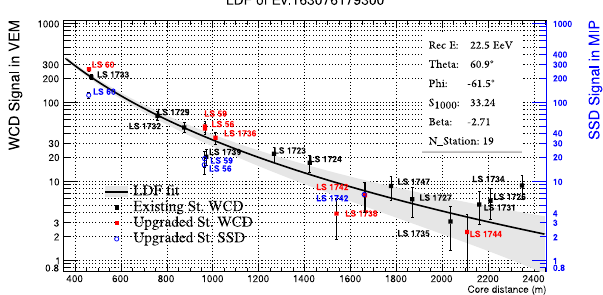
Figure 3: Left panel: WCD and SSD signals in the same station for an event. Right panel: Correlation between sizes of the SSD and WCD signals.